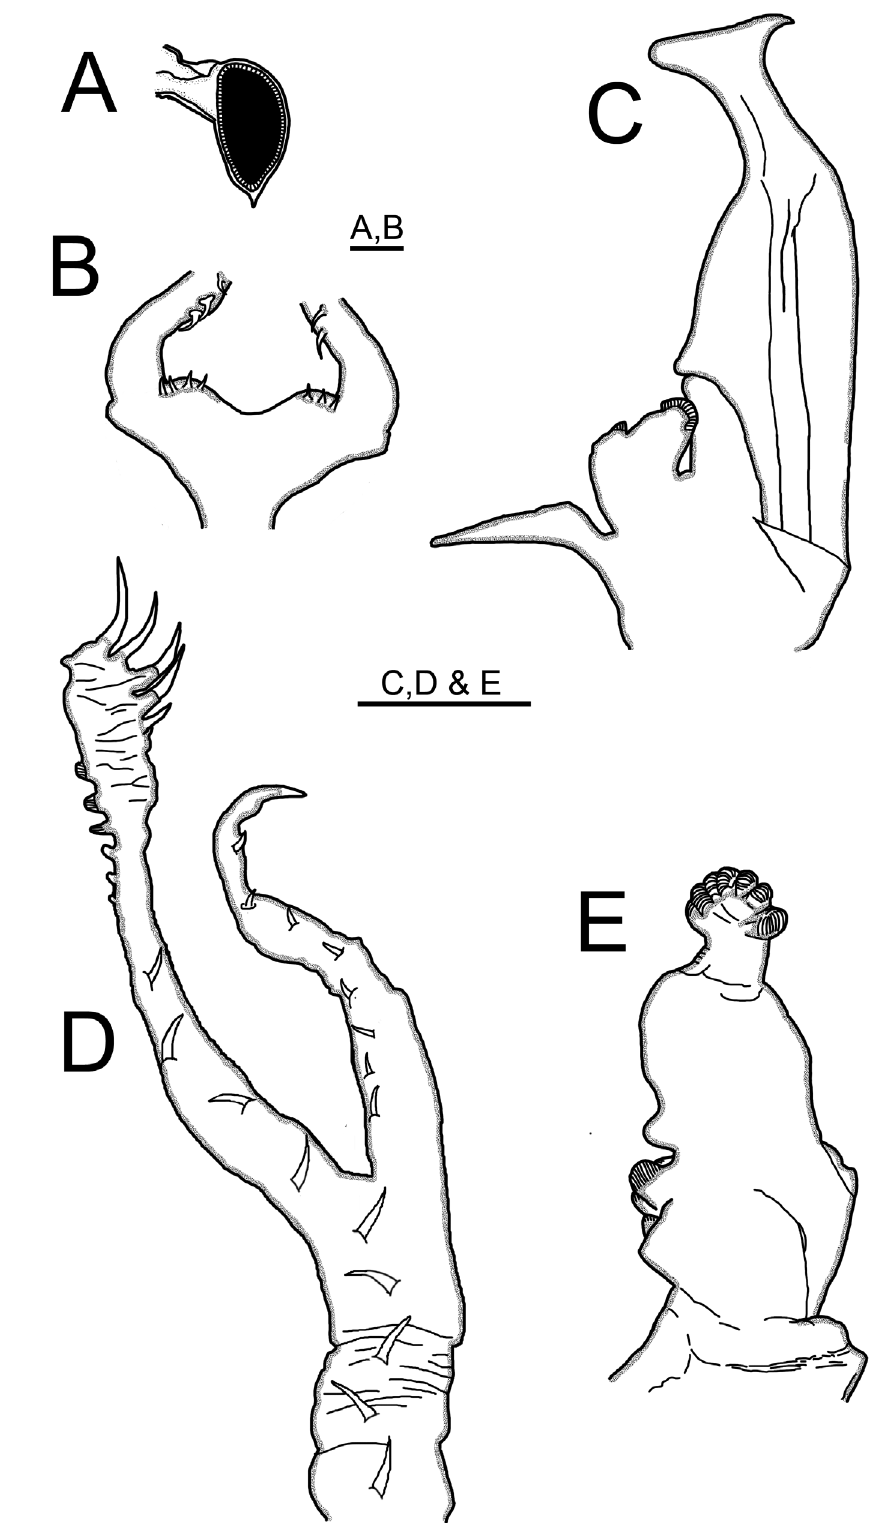
Fig. 2. Dendrocephalus aranai Rabet & Lacau sp. nov., ♂. A . Eye with a spine on the posterior edge. B . Basal part of the frontal appendage. C . Branch 2A of the frontal appendage. D . Branch 1V. E . Branch 2V. Scale bars: 1